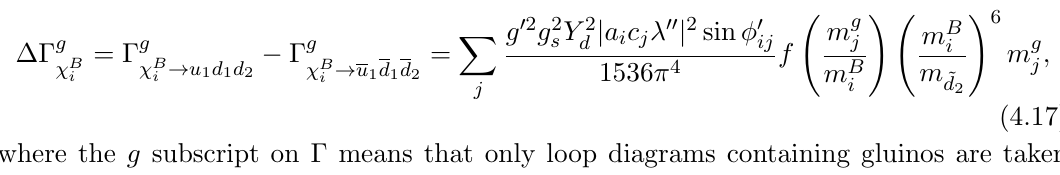
Figure 18. (a) Loop baryon number breaking decay of (cid:31) B breaking decay of (cid:31) B